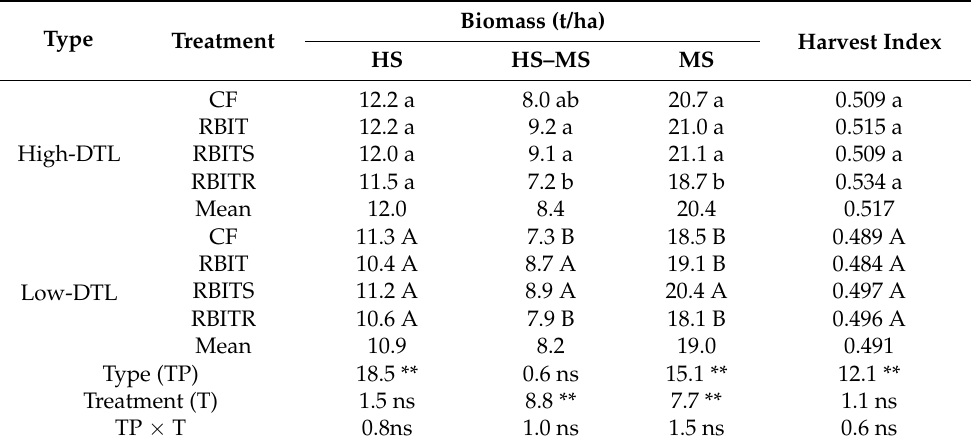
Table 3. Effect of fertilization management on biomass and HI at different growth stages and harvest index under High-DTL and